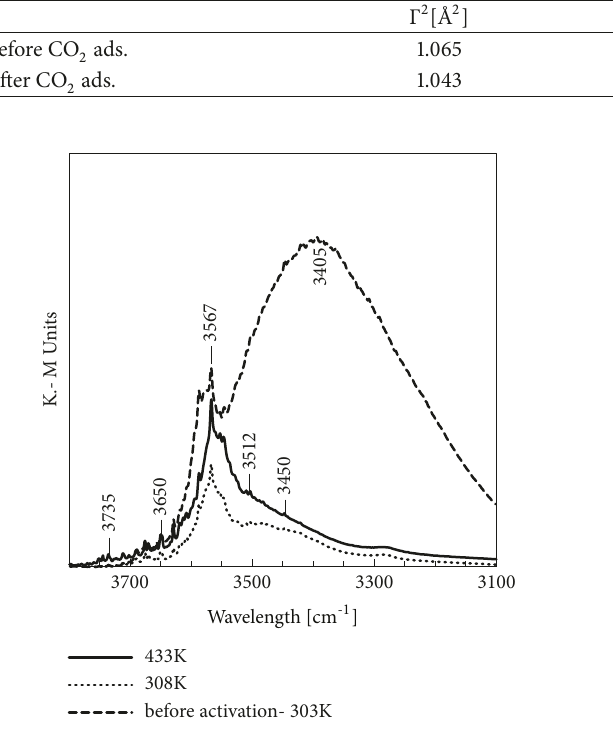
Figure 6: IR spectra for zeolite 5A before and after activation at 303 K and 433